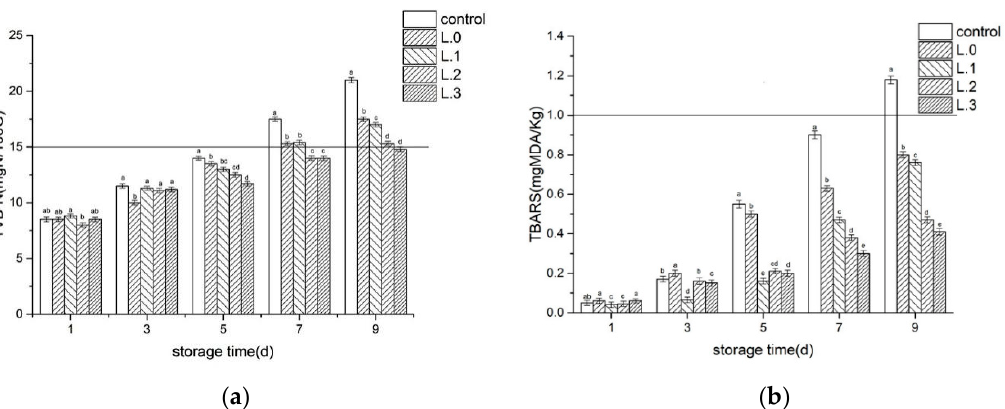
Figure 3. Effects of different treatments of chilled fresh pork on TVB-N ( a ) and TBARS ( b ) values Figure 3. E ff ects of di ff erent treatments of chilled fresh pork on TVB-N ( a ) and TBARS ( b ) values during during storage at 4 ° C for 9 d period. storage at 4 ◦ C for 9 d